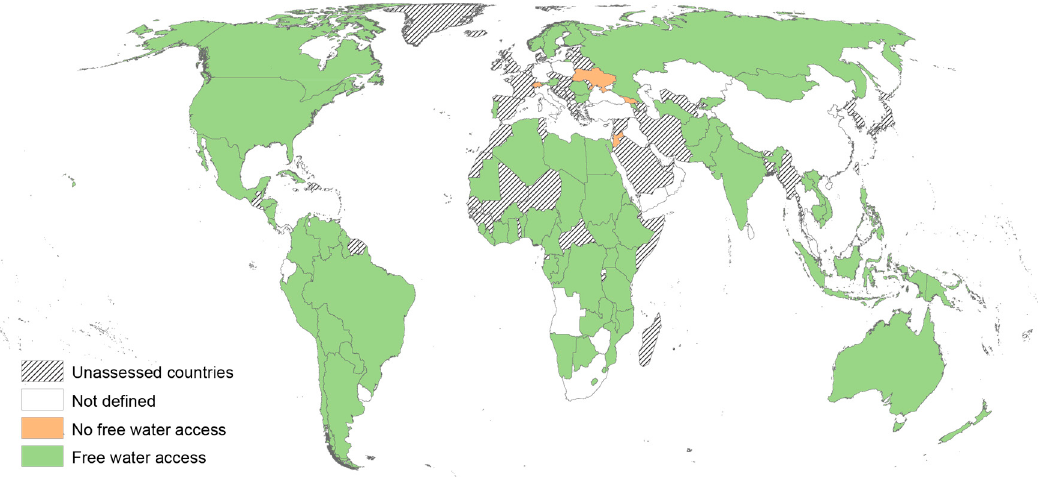
Figure 5. States whose laws guarantee free water for domestic purposes.